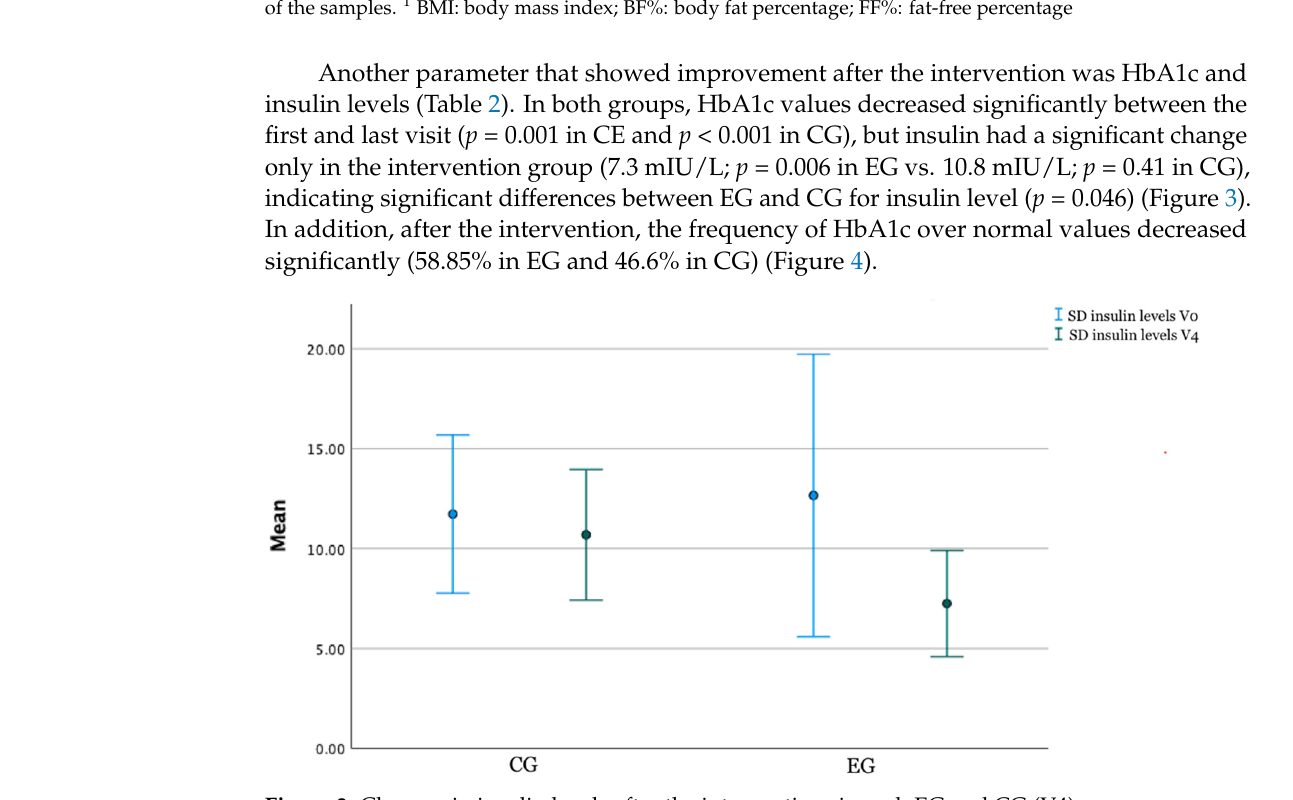
Figure 3. Changes in insulin levels after the interventions in each EG and CG (V4). According to the KIDMED test, showed that 44.8% of the sample ( n = 29) had low adherence to the Mediterranean Diet, 48.3% showed medium adherence, and only 6.9% showed good compliance with the healthy dietary model. The results of the KIDMED were 3.2 ± 2.1 (95% CI 2.01–4.39) for the CG and 4.57 ± 2.47 (CI 95% 3.14–5.99) for the EG, with no significant differences between groups at the beginning ( p = 0.69). After the intervention, and compared to CG (2.5; p = 0.012 EG vs. 1.89, p = 0.056 CG) (Figure 5). In this sense,